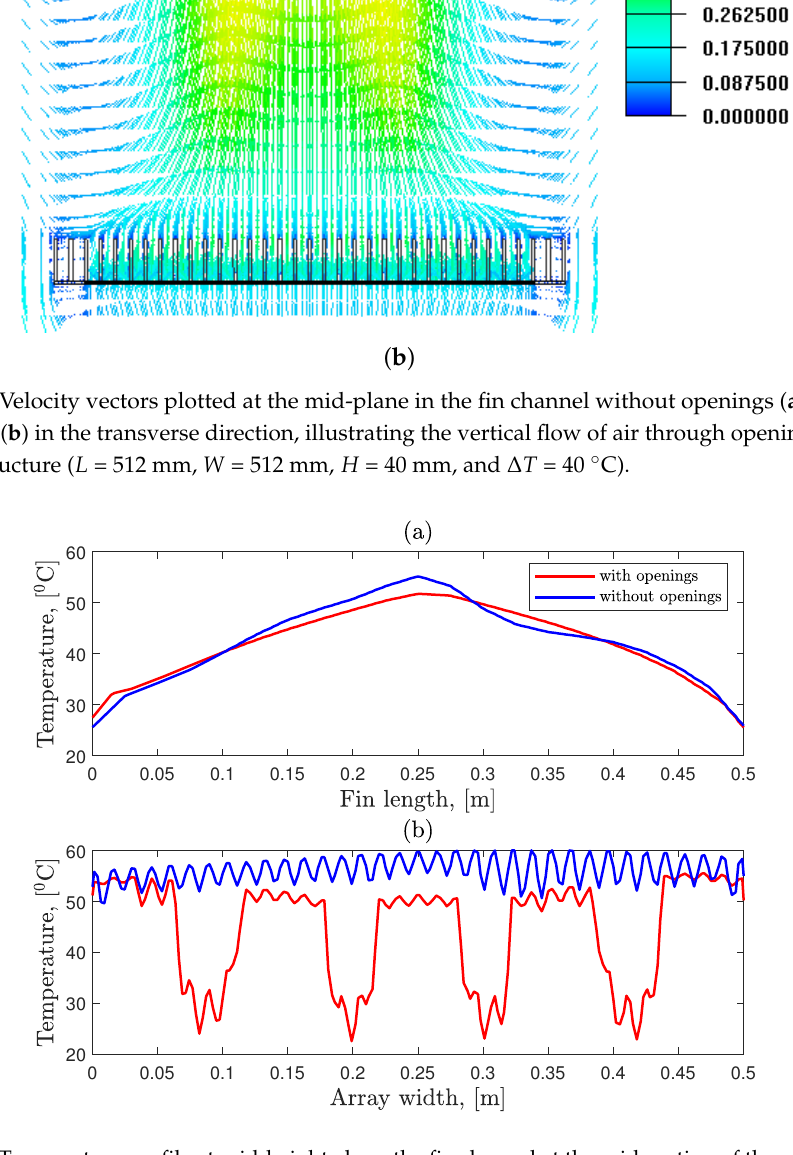
Figure 9. Temperature profile at mid-height along the fin channel at the mid-section of the optimum fin arrays with and without openings at the base ( a ) and along the transverse direction or width-wise ( b ). The minimum temperature in ( b ) indicates the openings ( L = 512 mm, W = 512 mm, H = 40 mm, and ∆ T = 40 ◦